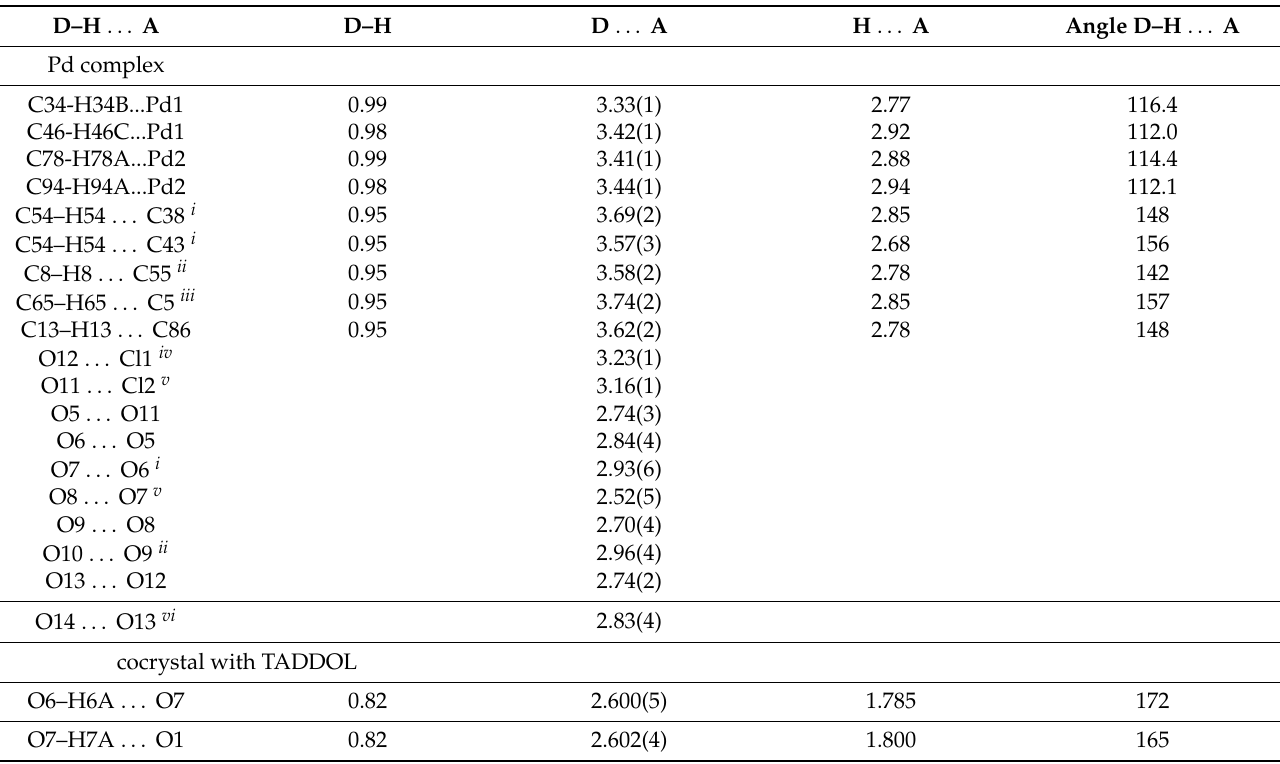
Table 20. Intra- and intermolecular contacts in Pd complex and cocrystal of 9 with